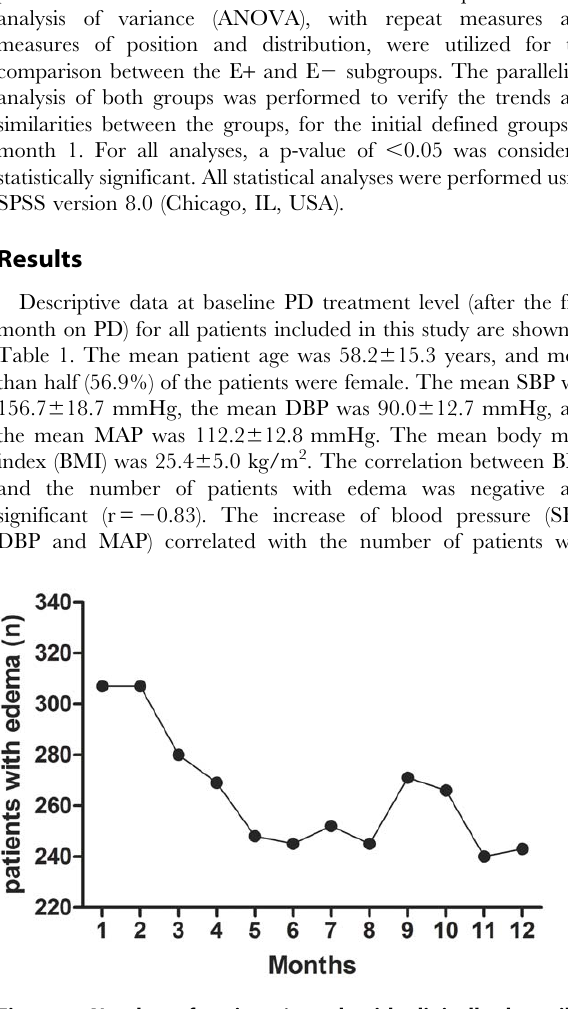
Figure 1. Number of patients/month with clinically detectible